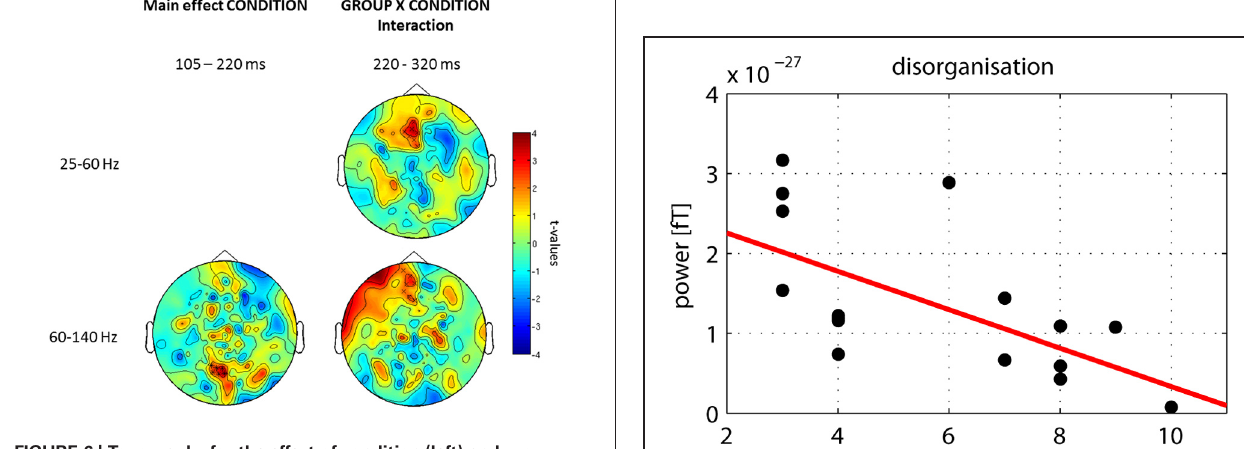
FIGURE 6 | Topography for the effect of condition (left) and group × condition (right) interaction for low and high gamma-band oscillations for three time windows (onset-response, induced period, offset-response). Red clusters indicate higher gamma-band power in the face vs. the no-face condition. The topographies depict corrected t -values and the sensors that form a statistically significant cluster are indicated ( ∗ , p < 0 . 001; x , p < 0 . 05).